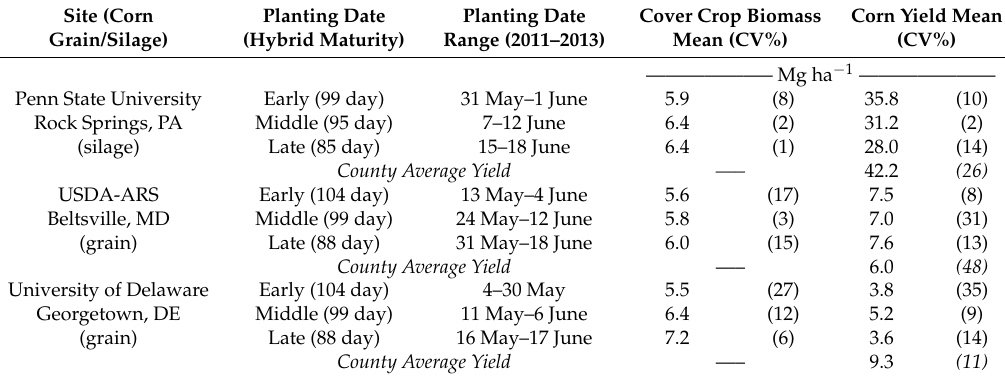
Table 2. Cover crop (hairy vetch/triticale) biomass and corn yields in an organic cover crop-based rotational no-till experiment (2011–2013) conducted by Pennsylvania State University (Rock Springs, PA), USDA Agricultural Research Service (ARS; Beltsville, MD, USA) and University of Delaware (Georgetown, DE, USA). Cover crop biomass and corn yields are averaged across treatments ( n = 2; +/ − high-residue cultivation), blocks ( n = 4) and years ( n = 3; 2011–2013) for the three planting date treatments (early, middle, late) evaluated in the experiment. The coefficient of variation (CV) is reported to describe inter-annual yield variability (2011–2013) among alternative planting date strategies and county-level average conventional